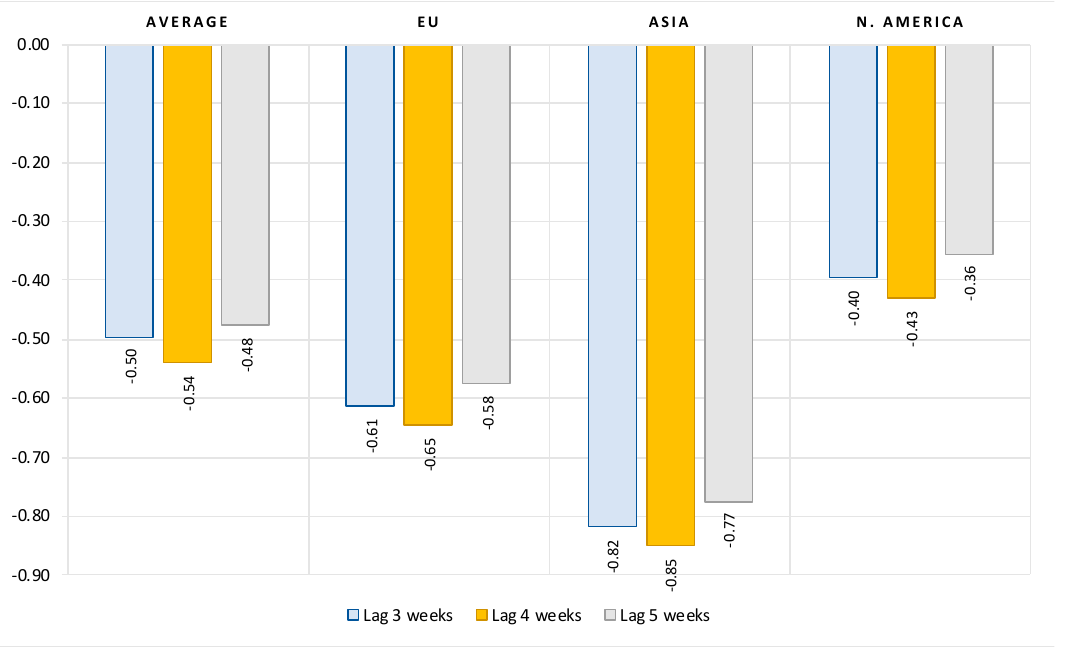
Figure 4. Impact of vaccination rate on number of new hospitalized patients, limited data sample *.